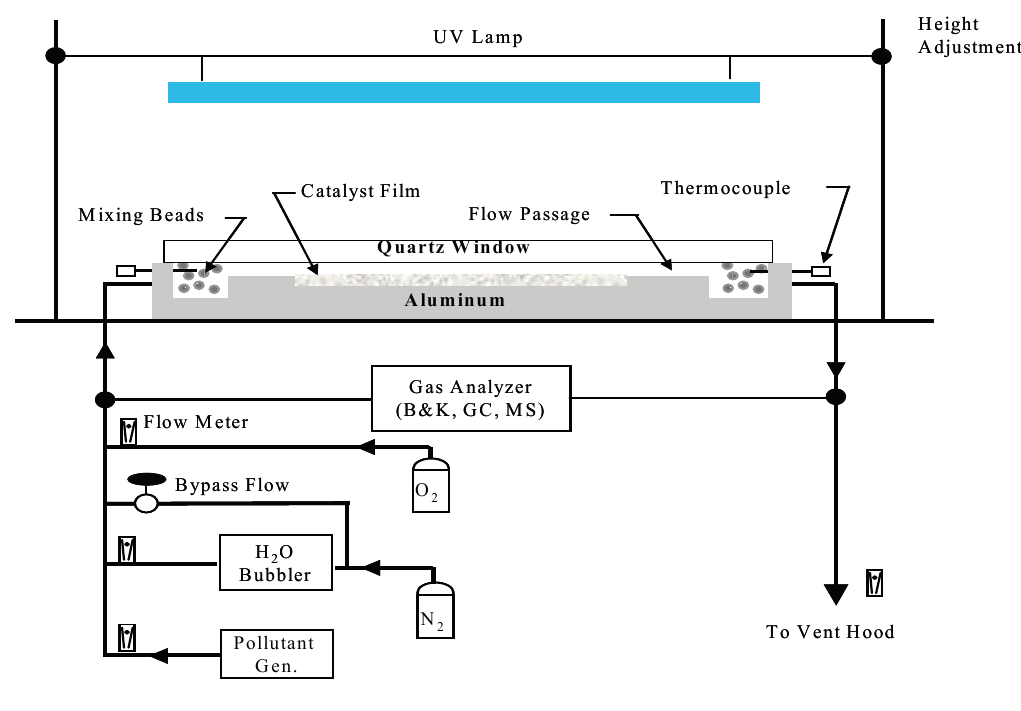
Figure 6. Photo-oxidation